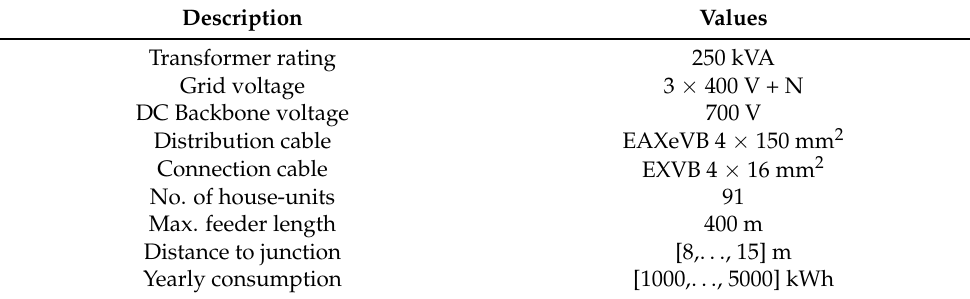
Table 1. Summary of the grid